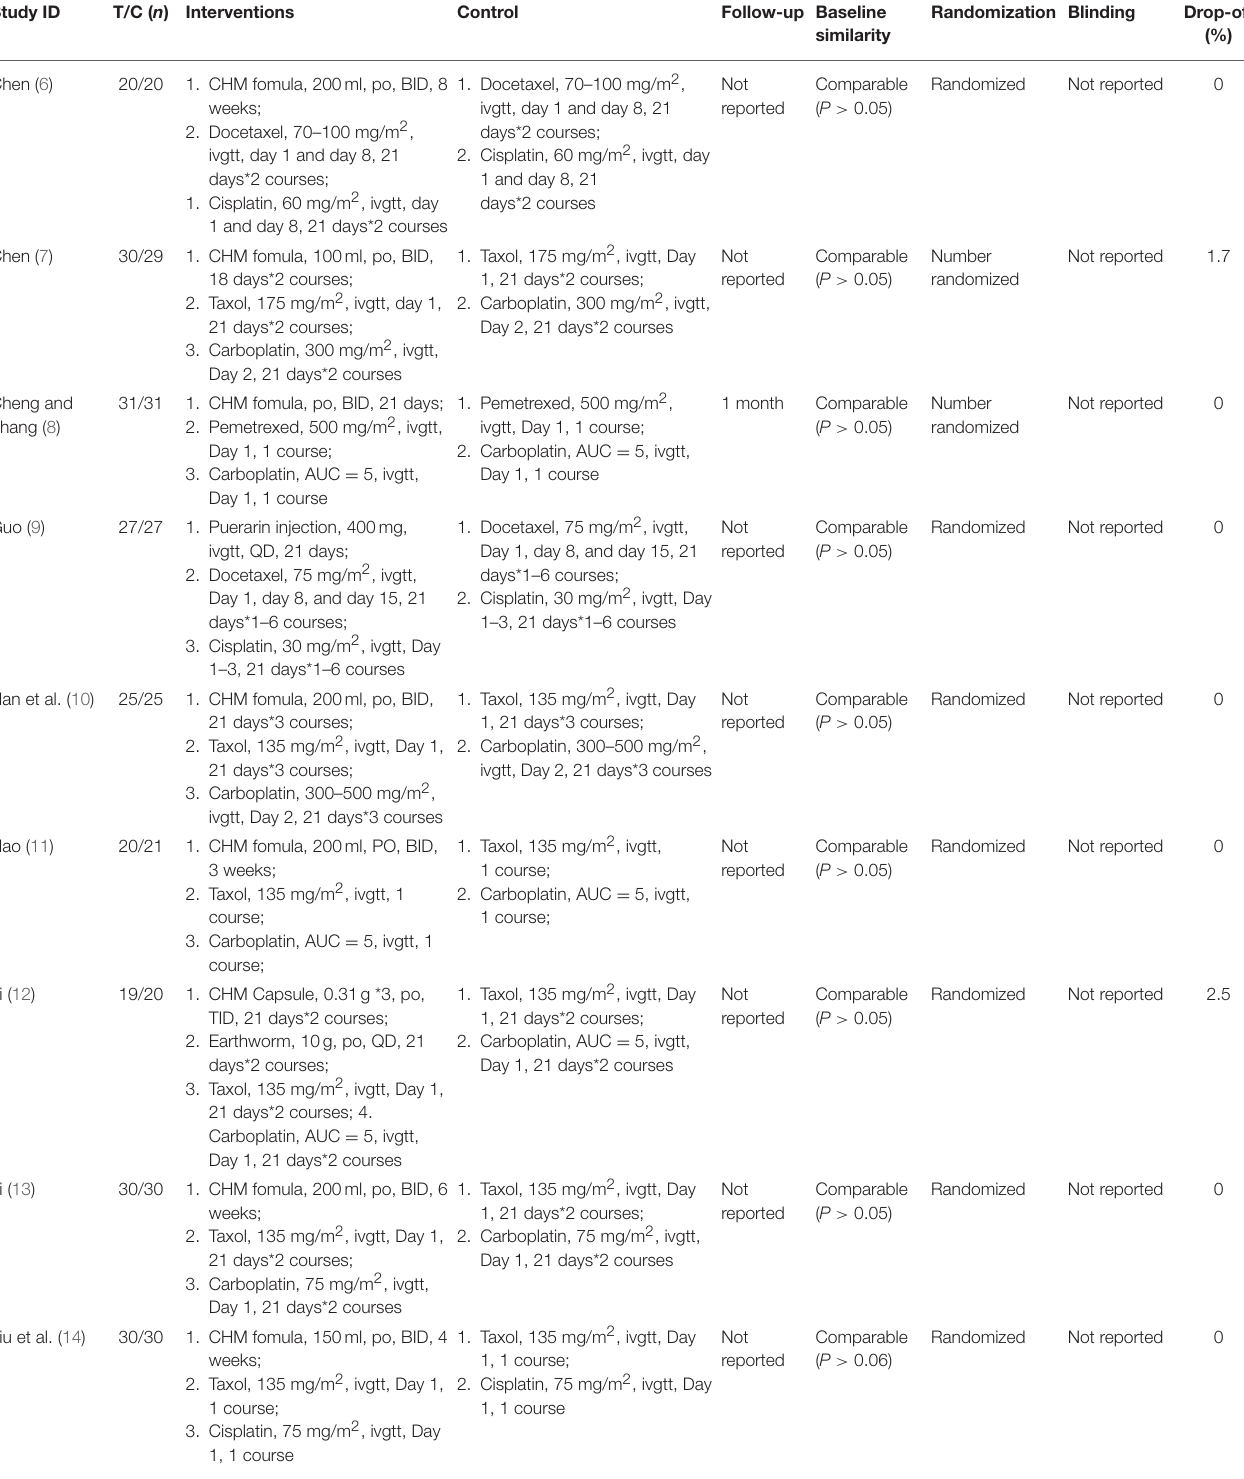
TABLE 1 | Summary of characteristics of included studies. Study